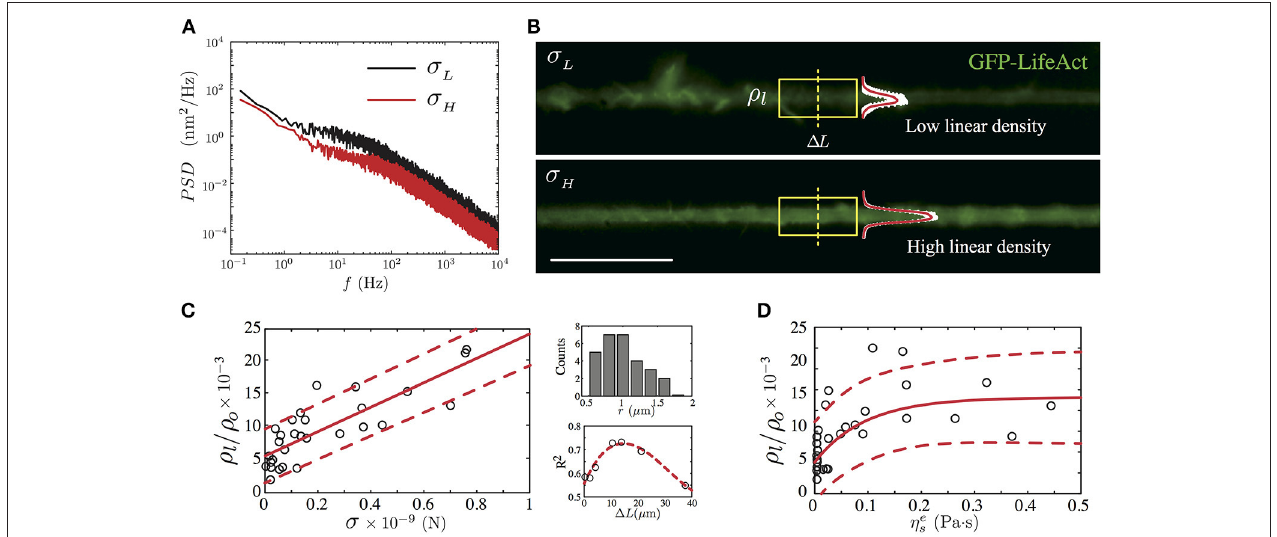
FIGURE 5 | GFP-LifeAct cytoskeleton imaging of PC12 neurite samples after 4 days of growth. (A) Power Spectrum Density of two PC12 neurites, where the black solid line represents a neurite whose mean fluctuation amplitude is of the order of 9.47 ± 0.15 nm and an axial tension value of 0.16 ± 0.01 nN, whereas the red solid line represents a neurite with a mean fluctuation amplitude value of 7.38 ± 0.16 nm and an axial tension value of 0.45 ± 0.04 nN. (B) Irregular F-actin distribution in a PC12 neurite with a low actin presence ρ l /ρ o = (4.24 ± 1.83) × 10 − 3 (top panel). Homogeneous F-actin distribution in a PC12 neurite with a high actin presence ρ l /ρ o = (12.76 ± 4.39) × 10 − 3 (bottom panel). The linear density is computed using the section framed in yellow. The mean intensity profile and its standard deviation are plotted to show the intensity variations in both cases. Scale bar 20 µ m. (C) The main panel shows the linear trend between the normalized linear F-actin density ( ρ l /ρ o ) and the neurite axial tension (the red solid line stand for the best linear fit). Whereas the secondary panels display the neurite radii distribution and the R-square correlation value as a function of the segment 1 L . (D) The dependency of the normalized linear F-actin density as a function of the neurite effective viscosity (the red solid line stand for the best exponential fit). The red segmented line represents the confidence bound with the 95 % of the data in the main plots of (C,D) . For the F-actin labeled version of the PC12, N = 28 neurites were imaged prior to the TFS